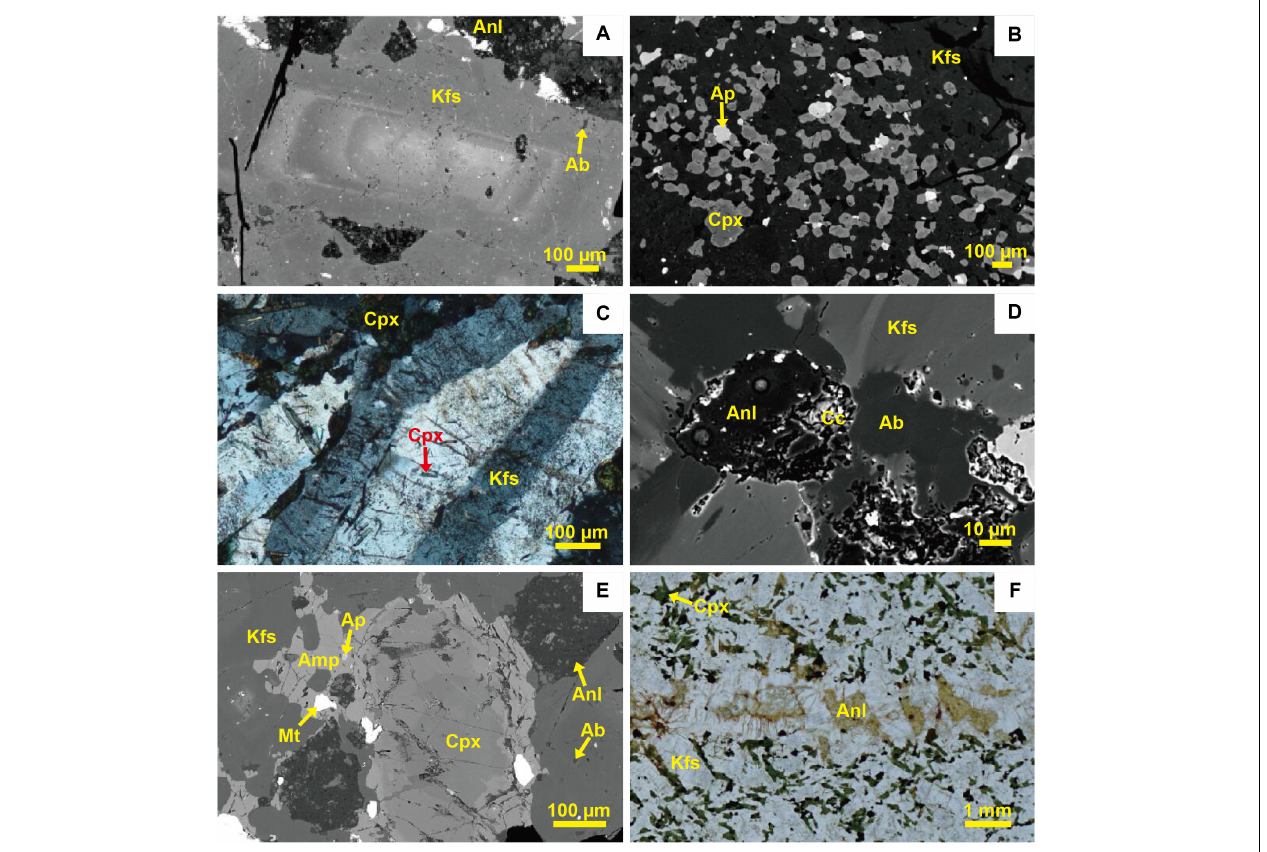
FIGURE 6 | Photos of syenite. (A) Zonation of K-feldspar in samples collected at the center of the syenite (BSE image). (B) Zoned anhedral clinopyroxenes scattered among K-feldspars (BSE image). (C) Acicular-shaped clinopyroxene crystals in the hosted K-feldspar crystals in the syenite samples close to the clinopyroxenite (plane-polarized light). (D) Co-existing K-feldspar, exsolved albite, analcite and calcite (BSE image). (E) Anhedral amphibole surrounds zoned clinopyroxene (BSE image). (F) Analcite vein (scanned photo of thin section). Ab, Albite; Amp, Amphibole; other abbreviations are as